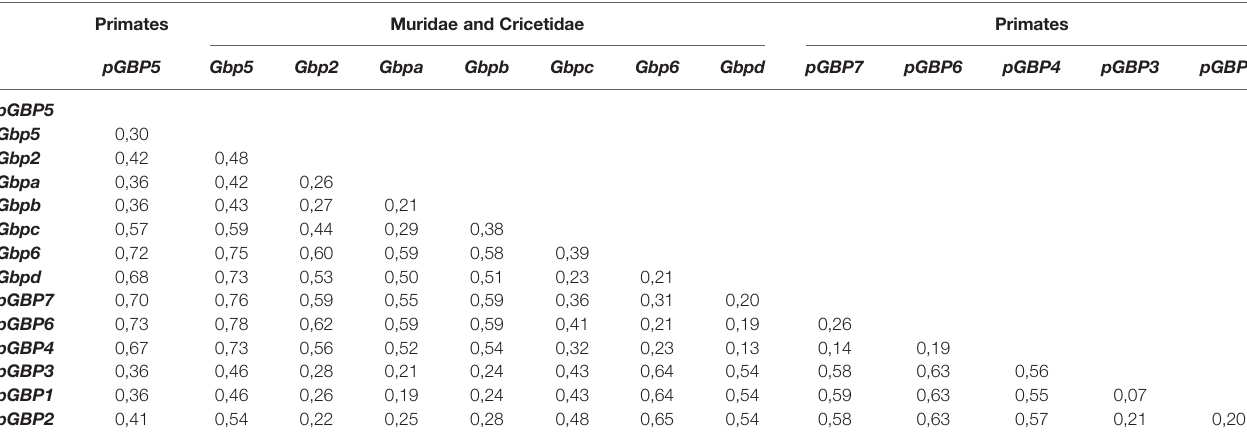
TABLE 2 | Estimates of net evolutionary divergence between Gbp groups of